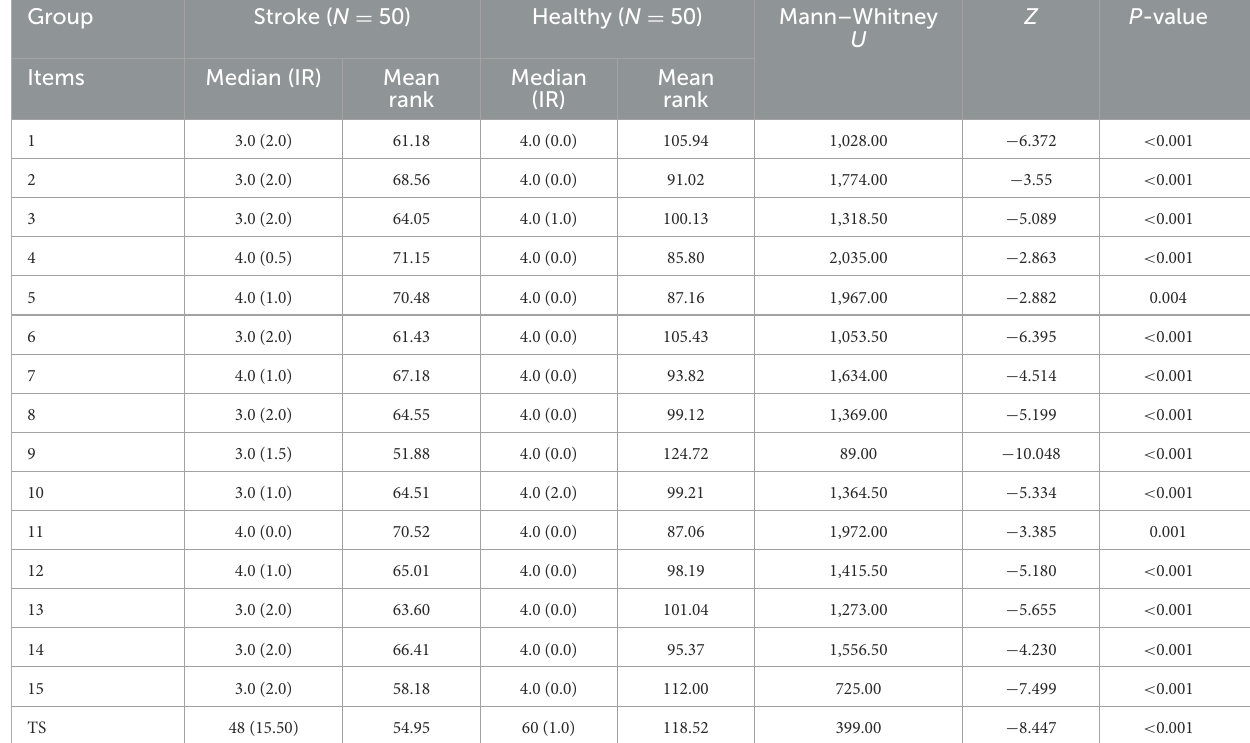
TABLE 4 Known-group validity of C-UEFI ( N =